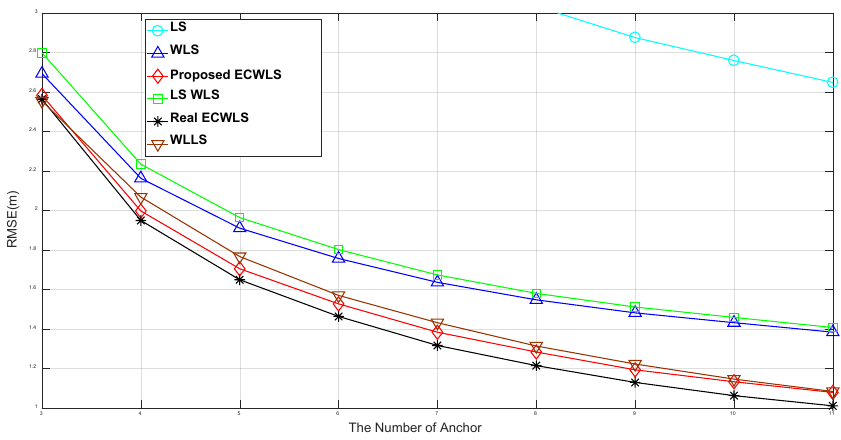
Figure 3. Root mean square error (RMSE) vs. the number of anchor nodes.